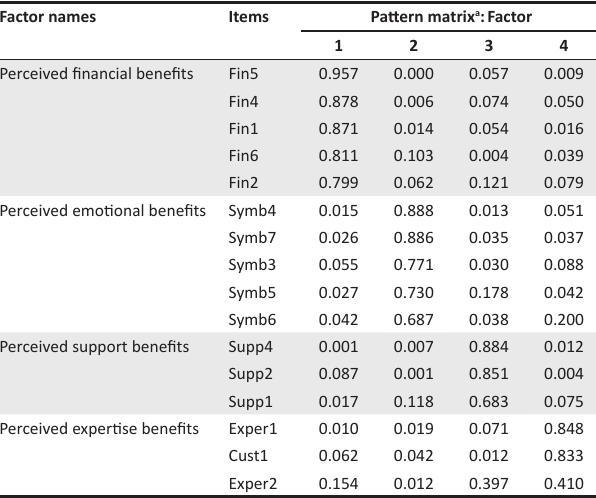
TABLE 2: Results of the exploratory factor analysis. Factor names